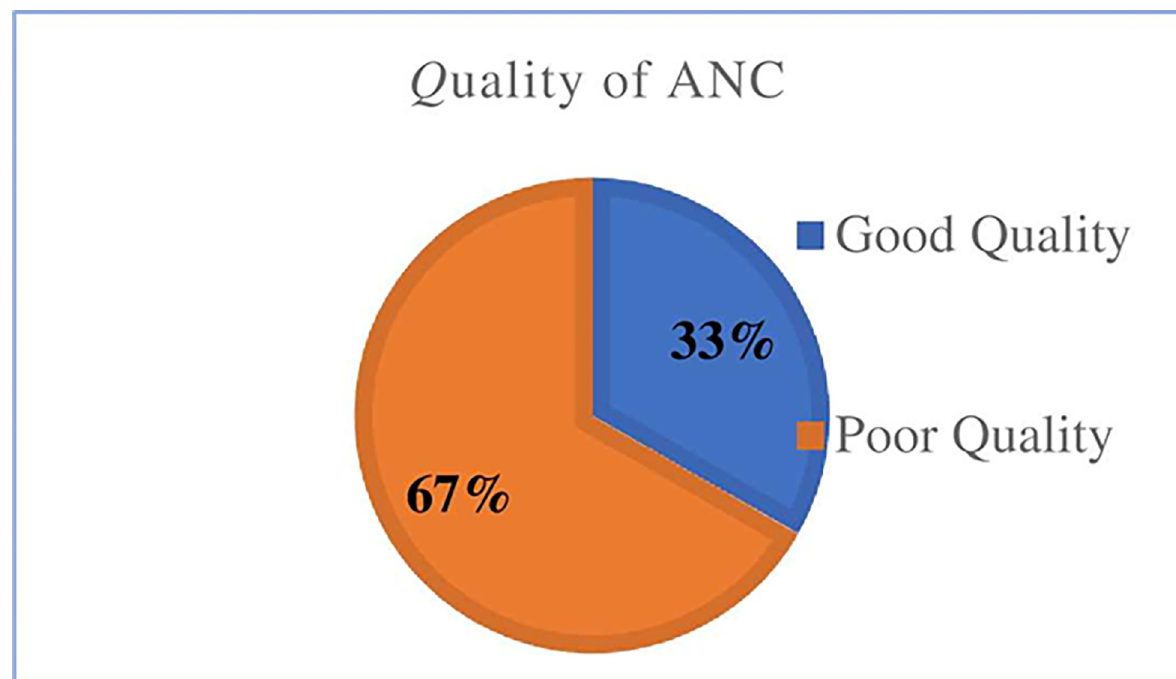
Fig 1. Quality of ANC service in selected public health centers in Addis Ababa, Ethiopia, 2020 (n = 609).